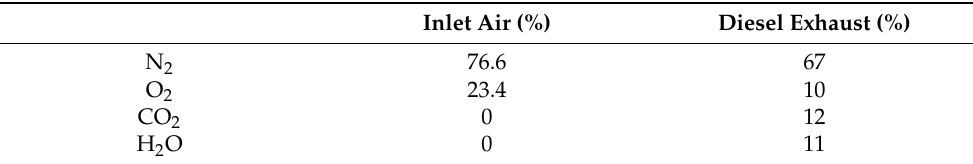
Table 4. Typical compositions of inlet air and exhaust